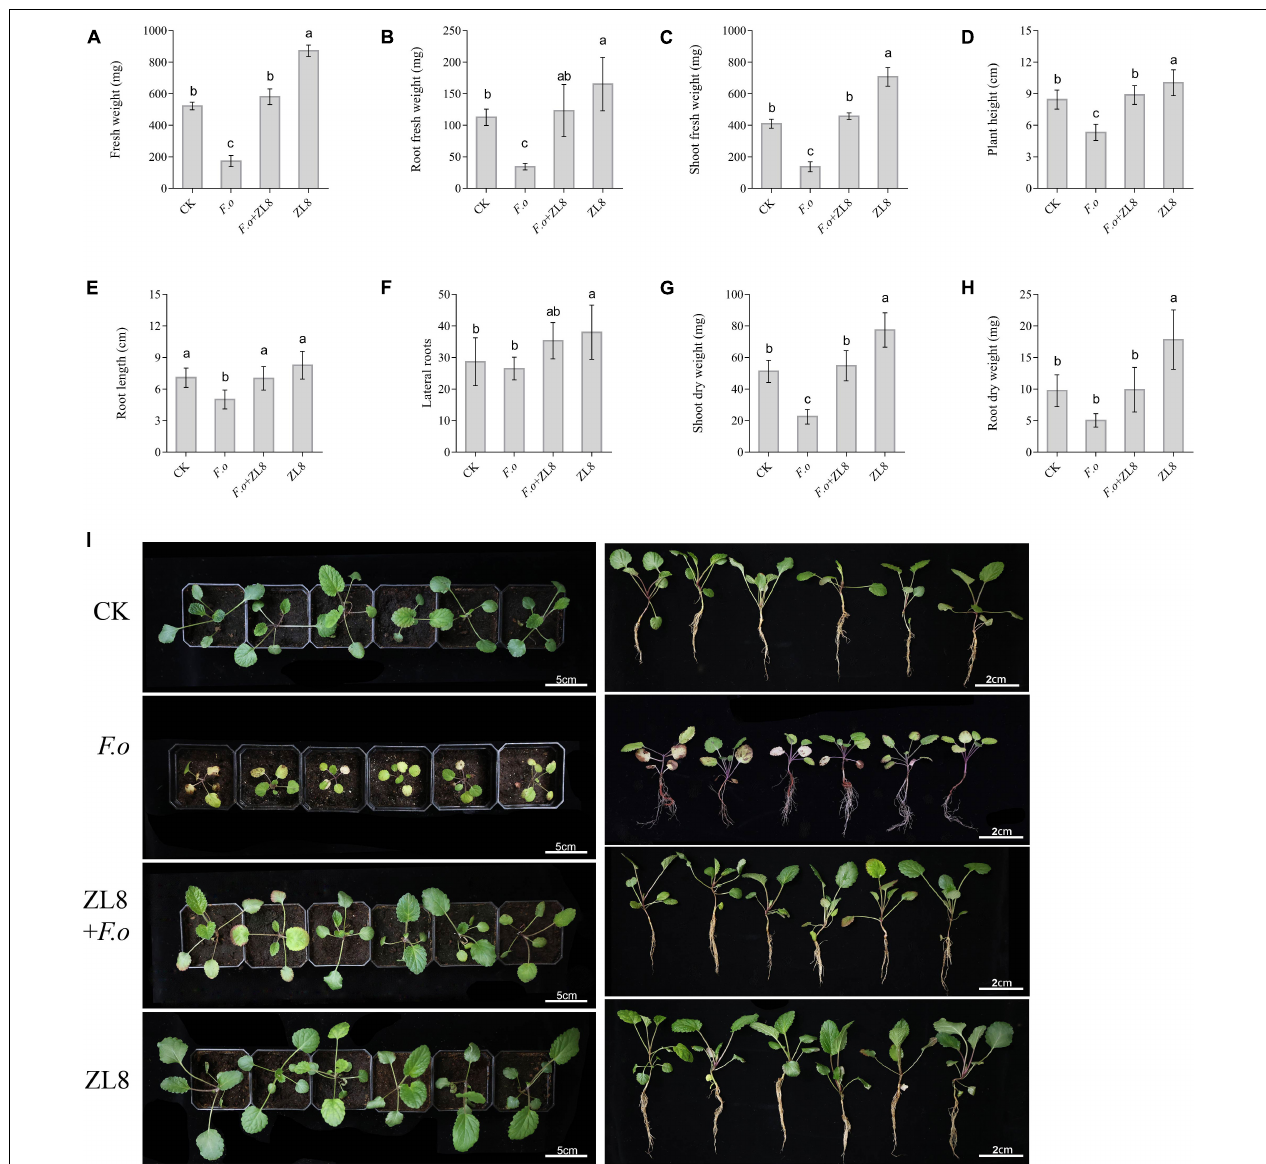
FIGURE 4 | Effects of ZL8 inoculation on seedling growth of Salvia miltiorrhiza . (A) : Fresh weight, (B) : root fresh weight, (C) : shoot fresh weight, (D) : plant hight, (E) : root length, (F) : lateral root, (G) : shoot dry weight, (H) : root dry weight, and (I) : Phenotype of S. miltiorrhiza with different treatment groups. Seedlings were taken image and biomass were measured after 30 days inoculate to bacterials suspension and double-sterile distilled water, respectively. Values are means and bars indicate SDs ( n = 6). Columns with different letters indicate significant difference at P < 0.05 (Duncan